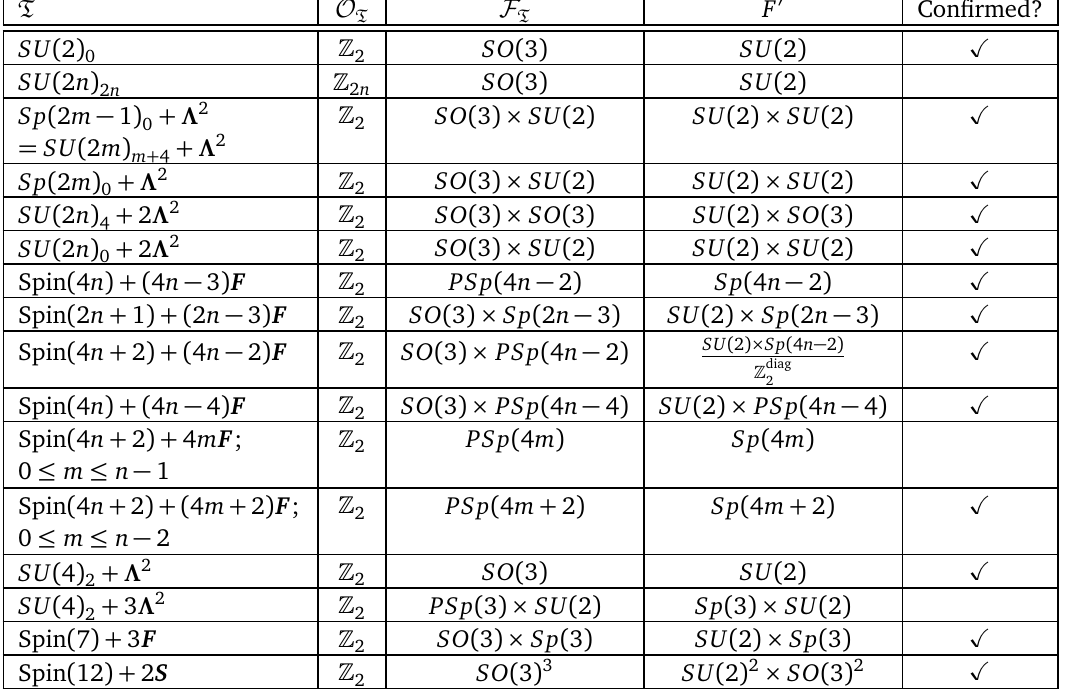
Table 1: Various 5d SCFTs exhibiting 2-group symmetries. T labels the theory, O the 1-form symmetry, F the global flavor symmetry group. The last column indi- cates whether the Postnikov class is known or not. See text for details on how to read the table. (cid:90) diag is the diagonal (cid:90) subgroup of the center (cid:90) SU 2 2 ( 2 ) SU ( 2 ) × Sp ( 4 n − 2 ) , where (cid:90) SU is the center of SU ( 2 ) and (cid:90) Sp 2